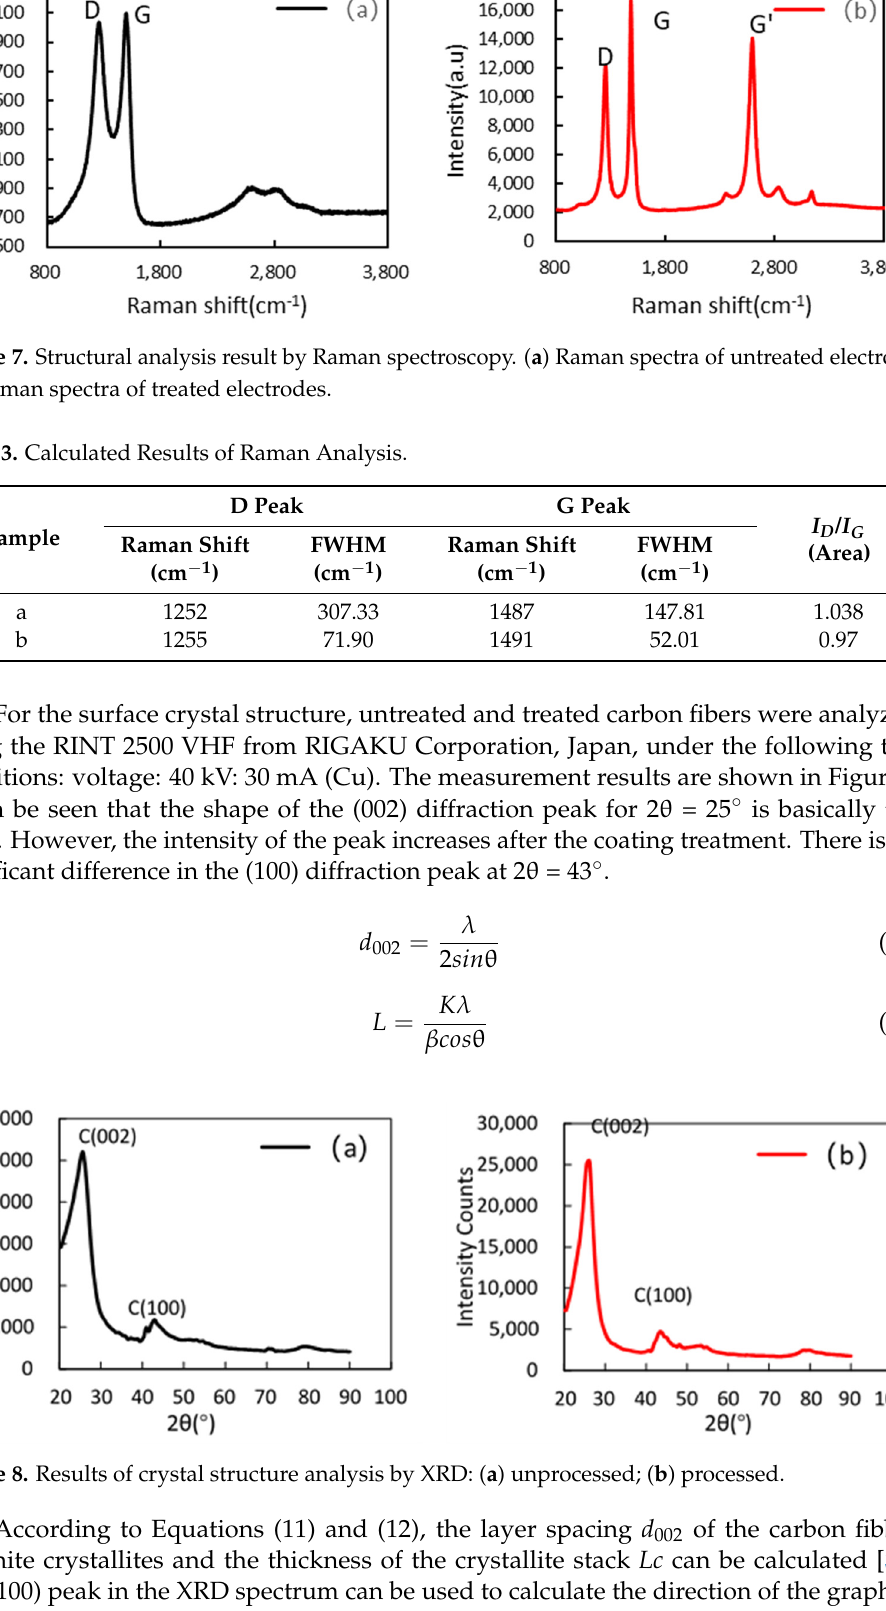
Table 4. XRD Patterns of Untreated and Treated Carbon Felts (a: Untreated; b: Treated Carbon Felts). CF